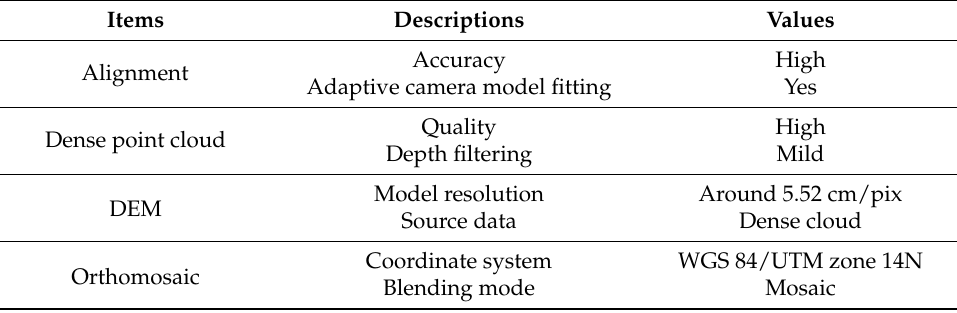
Figure 7. Flowchart of the entire procedure for generating orthomosaic and digital surface model from the collected UAV imagery. Table 5. Parameters of the UAV flights and Agisoft Photoscan processing used in the study.